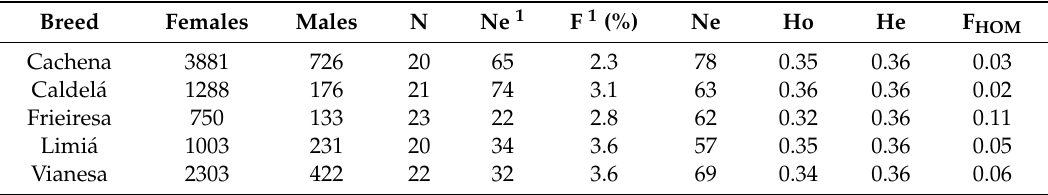
Table 1. Breeds names and number of samples analyzed per breed. E ff ective population size (Ne), observed and expected heterozygosity (H O and H E , respectively) and methods of moments inbreeding coe ffi cient (F HOM